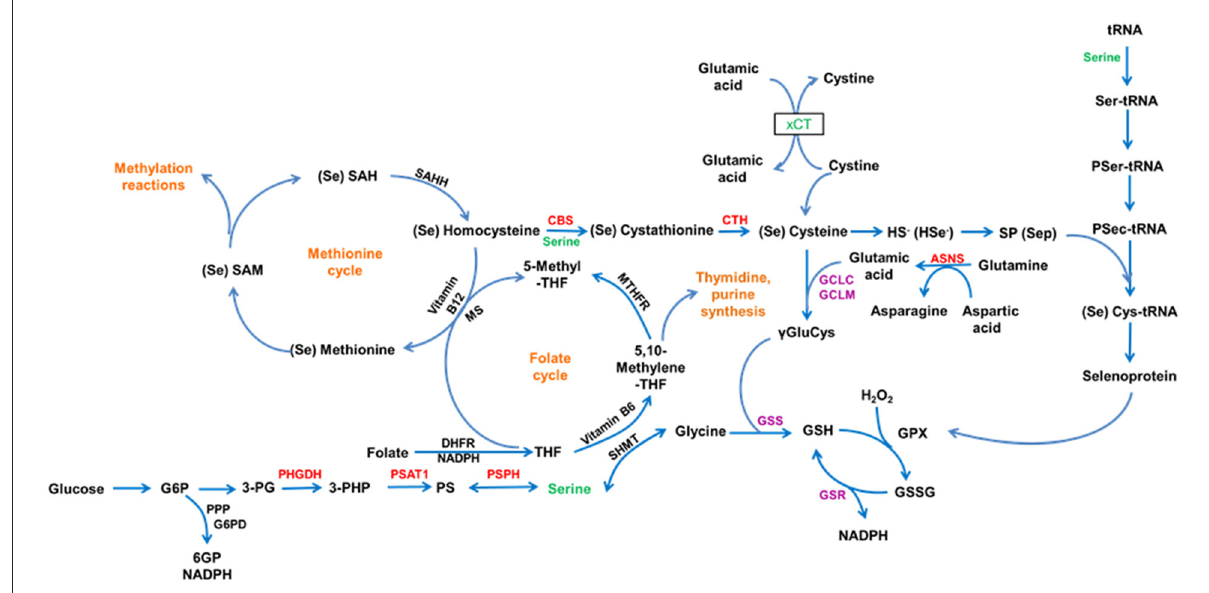
FIGURE10 This schematic illustrates the role of Serine in selenium metabolism and function.